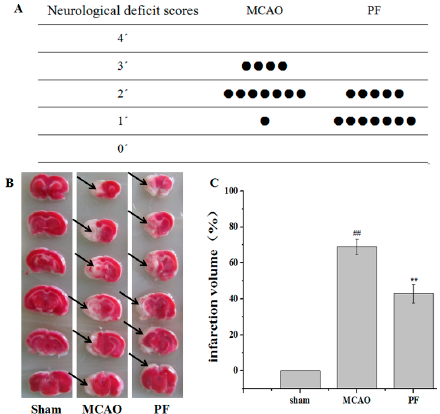
Figure 1. Effects of paeoniflorin (PF) on neurological deficit scores and cerebral infarct. ( A ) The neurological score of middle cerebral artery occlusion (MCAO) groups and PF groups ( n = 12); ( B ) Representative photographs showing the cerebral infarct of rat brain slices measured by 2,3,5-triphenyltetrazolium chloride (TTC) staining. Black arrow indicated ‘‘infarcted area’’; ( C ) The infarct volume of MCAO groups and PF groups. All data were expressed as mean ± SD. ## p < 0.01 vs. sham, ** p < 0.01 vs. MCAO.